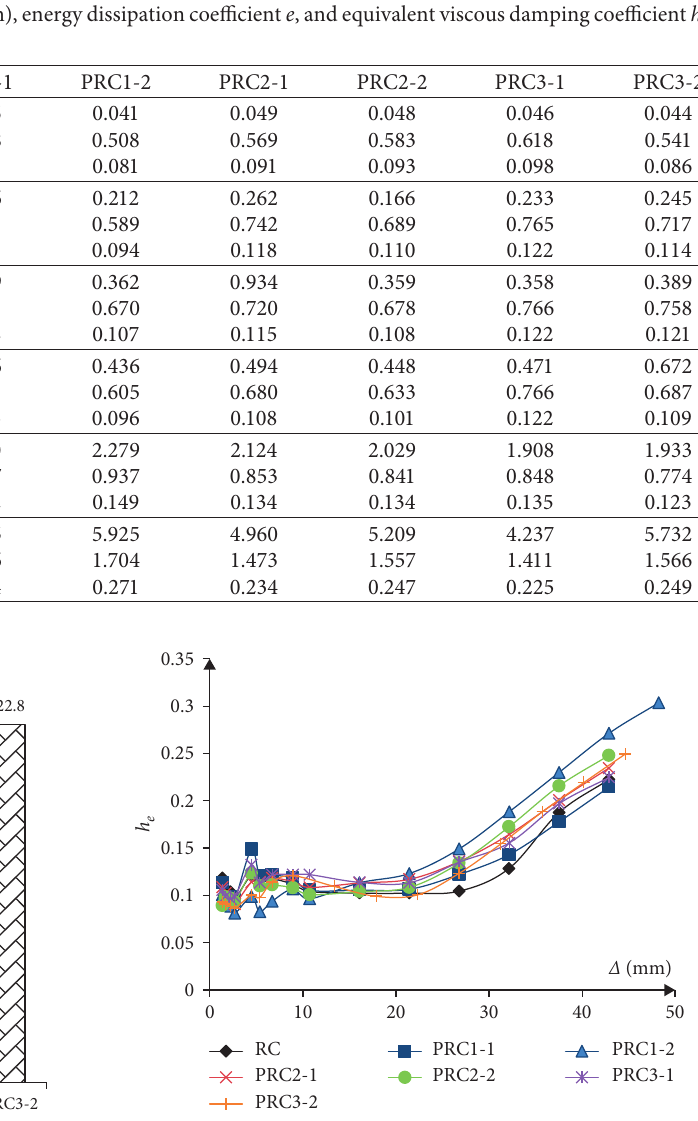
Figure 11: Comparison of cumulative energy consumption of specimens.